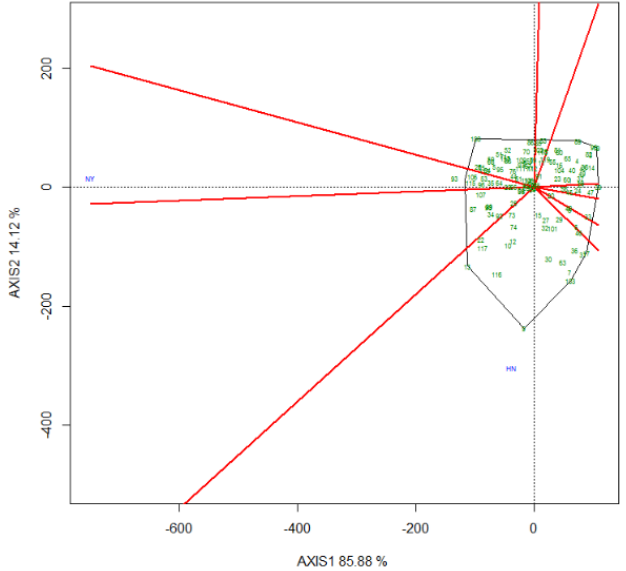
Figure 4. Suitable genotypes for the Mega–environment (ME) with respect to height. ME is the location sandwiched within the two neared red lines, and the genotype of the polygon vertex in the ME is the best genotype for this location [9]. Same as in Figure 7.